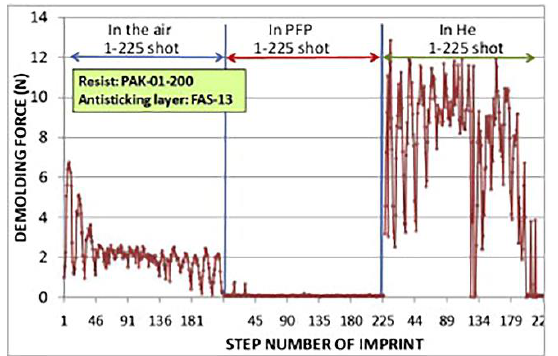
Figure 2. Difference in demolding forces (i.e., maximum force required for separating the mold and the resist after imprinting) between UV-NIL atmospheres of air, pentafluoropropane (PFP), and helium. Reprinted with permission from [34]. Copyright 2015 Elsevier.